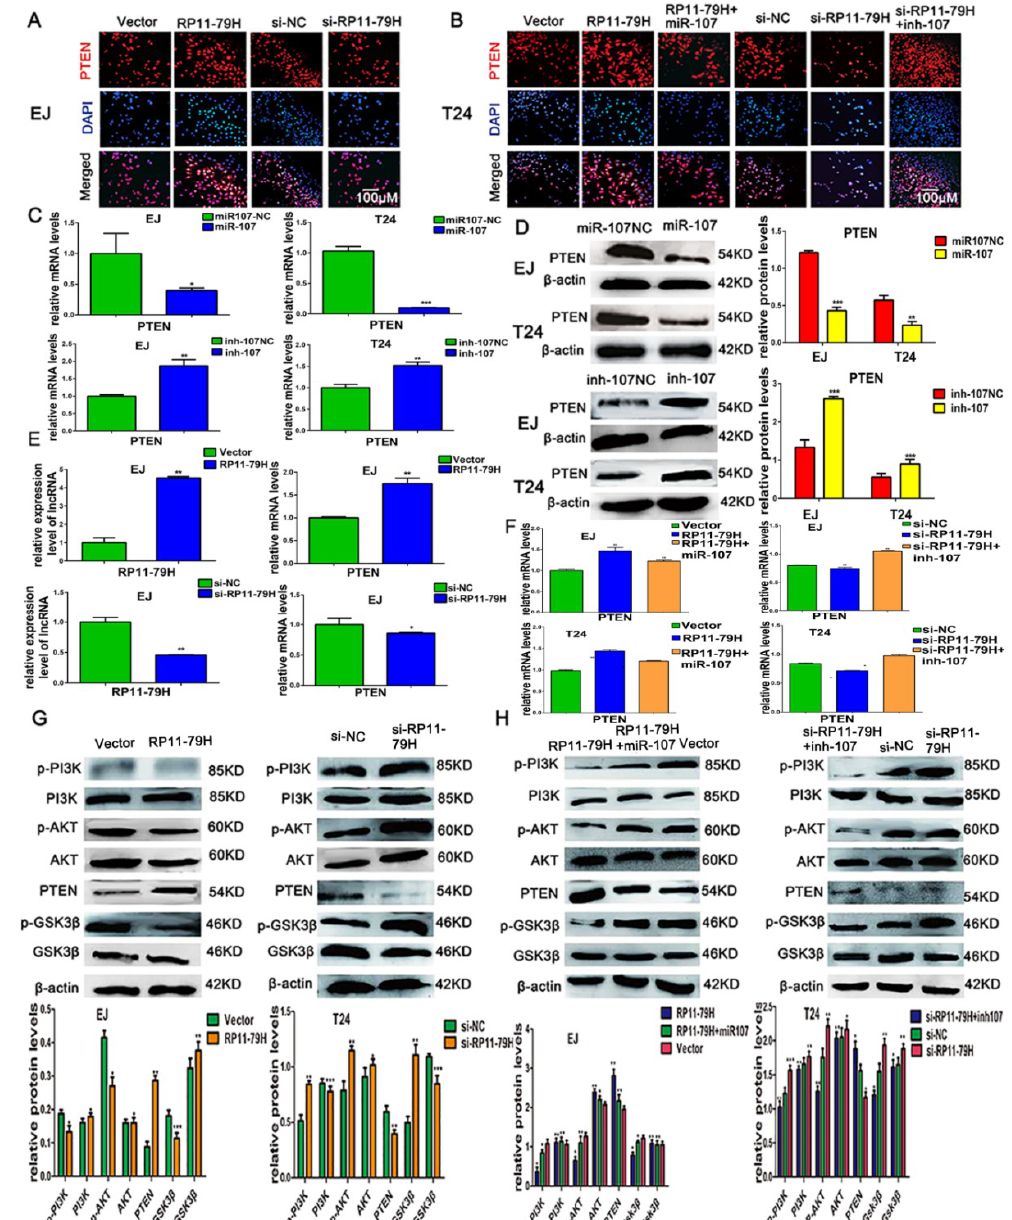
Figure 7. RP11-79H23.3 and miR-107 impact the expressions of the target gene PTEN and PI3K/AKT signaling pathway molecules in vitro. ( A , B ) Immunofluorescent assays were used to detect the expressions of PTEN in EJ and T24 cells transfected with pIRES2-RP11-79H23.3 or siRP11-79H23.3 or pIRES2-RP11-79H23.3 and miR-107 mimics or siRP11-79H23.3 and inh-107 (scale bar, 100 µm). ( C ) The mRNA levels of PTEN were determined by qRT-PCR in EJ and T24 cells after being transfected with miR-107 mimics or inhibitors. ( D ) The protein levels of PTEN were determined in EJ and T24 cells transfected with miR-107 mimics or inhibitors by Western blotting. ( E ) The expressions of RP11-79H23.3 and PTEN were detected in cells transfected with pIRES2-RP11-79H23.3 and si RP11-79H23.3 by qRT-PCR. ( F ) qRT-PCR assays were performed to detect the mRNA levels of PTEN in EJ and T24 cells transfected with pIRES2-RP11-79H23.3 or siRP11-79H23.3 or pIRES2-RP11-79H23.3 and miR-107 mimics or siRP11-79H23.3 and inh-107. ( G , H ) The expressions of PTEN and PI3K/AKT signaling pathway molecules were assayed in BC cells transfected with the indicated plasmids or siRNAs or pIRES2-RP11-79H23.3 and miR-107 mimics or siRP11-79H23.3 and inh-107 by Western blotting. Each experiment was independently repeated at least three times. Data are shown as mean ± SD, * p < 0.05, ** p < 0.01, *** p < 0.001.